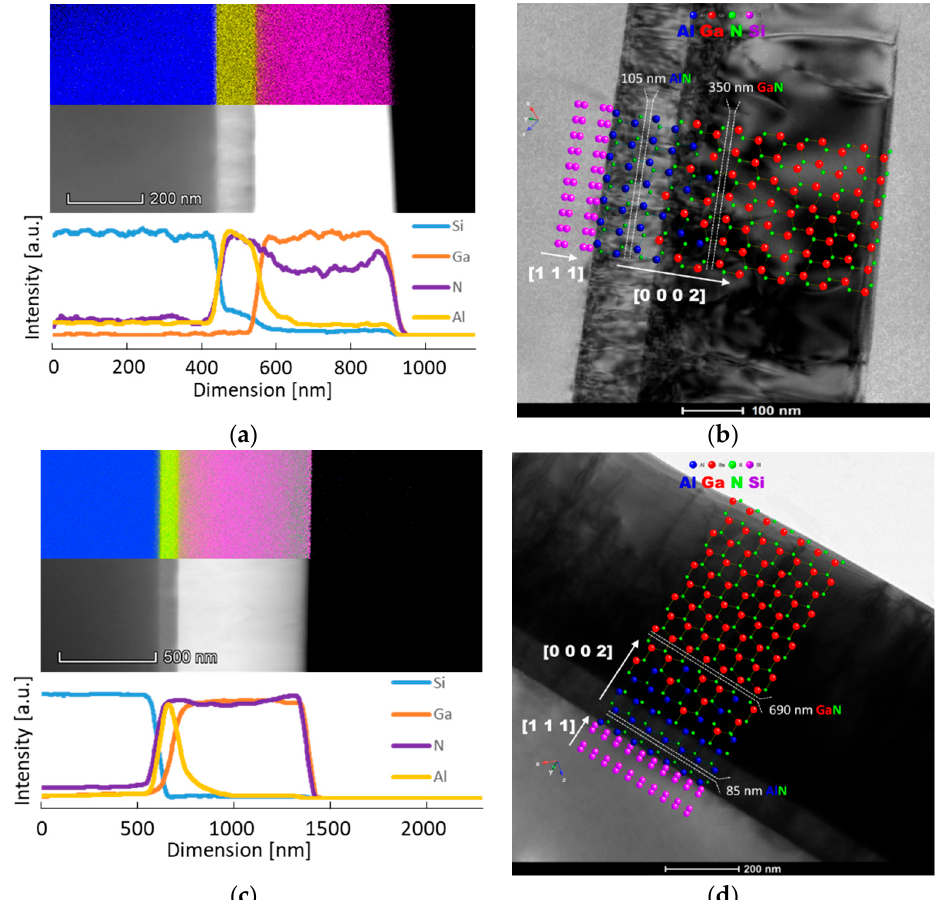
Figure 3. STEM micrographs with EDS mapping and elemental line profiles for ( a ) GaN300/Si, ( c ) GaN700/Si, and TEM micrographs showing the overview of the two wafers, ( b ) and ( d ), respectively.